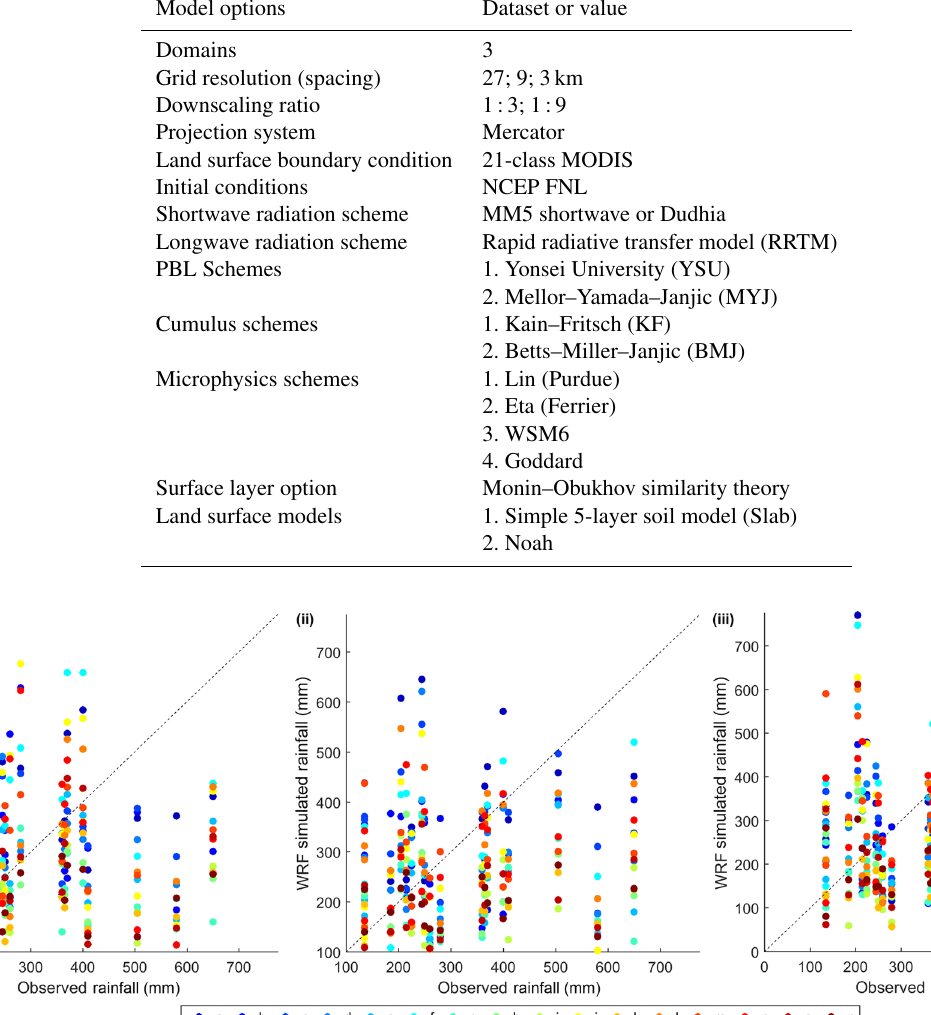
higher error and variability in the simulations for the northern part of the domain compared to the southern part. This is likely due to the complex terrain in the northern part of the